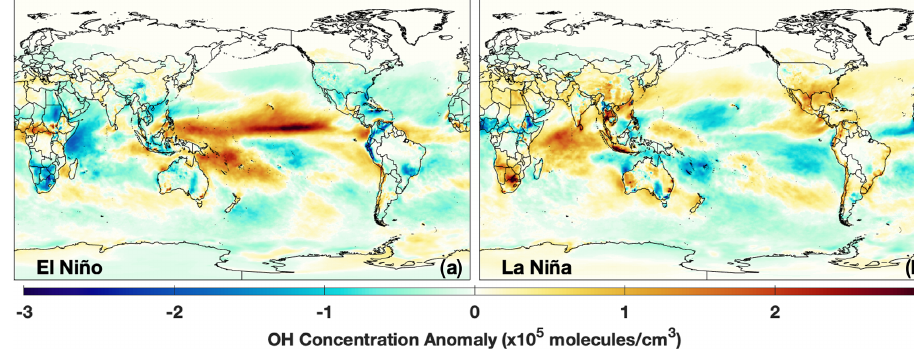
Figure 10. Same as panels (a) and (b) of Fig. 7 except for the PBL level.